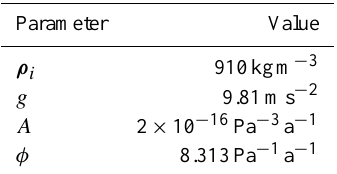
Table 2. List of parameter values involved in the computation of ice